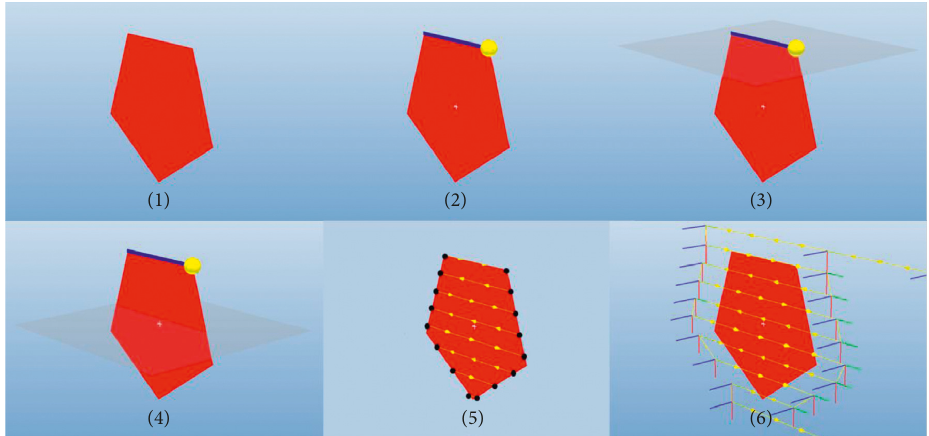
Figure 8: Autogeneration on a straight-edge polygon